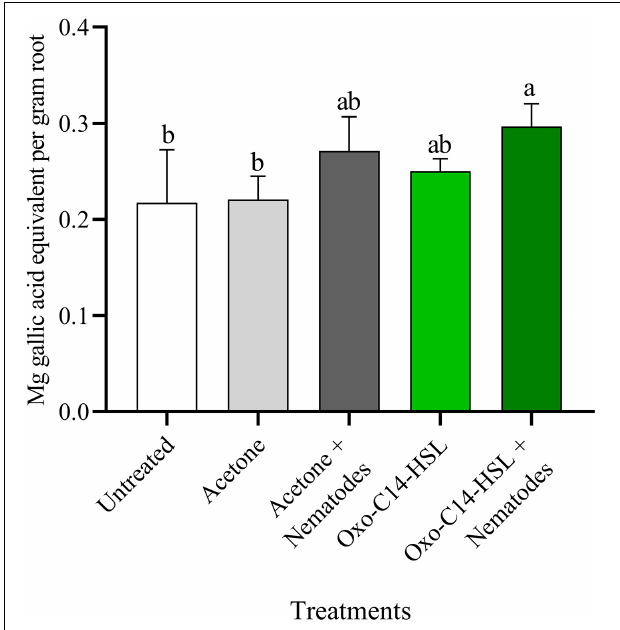
FIGURE 9 | Quantification of total phenolic compounds in roots of oxo-C14-HSL primed and non-primed plants of soybean cv. Primus. Total phenolic compounds were quantified according to the Folin-Ciocalteu method by spectrophotometry at an absorbance of 765 nm and normalized to gallic acid. Different letters indicate significant differences among treatments in Tukey’s test ( n =